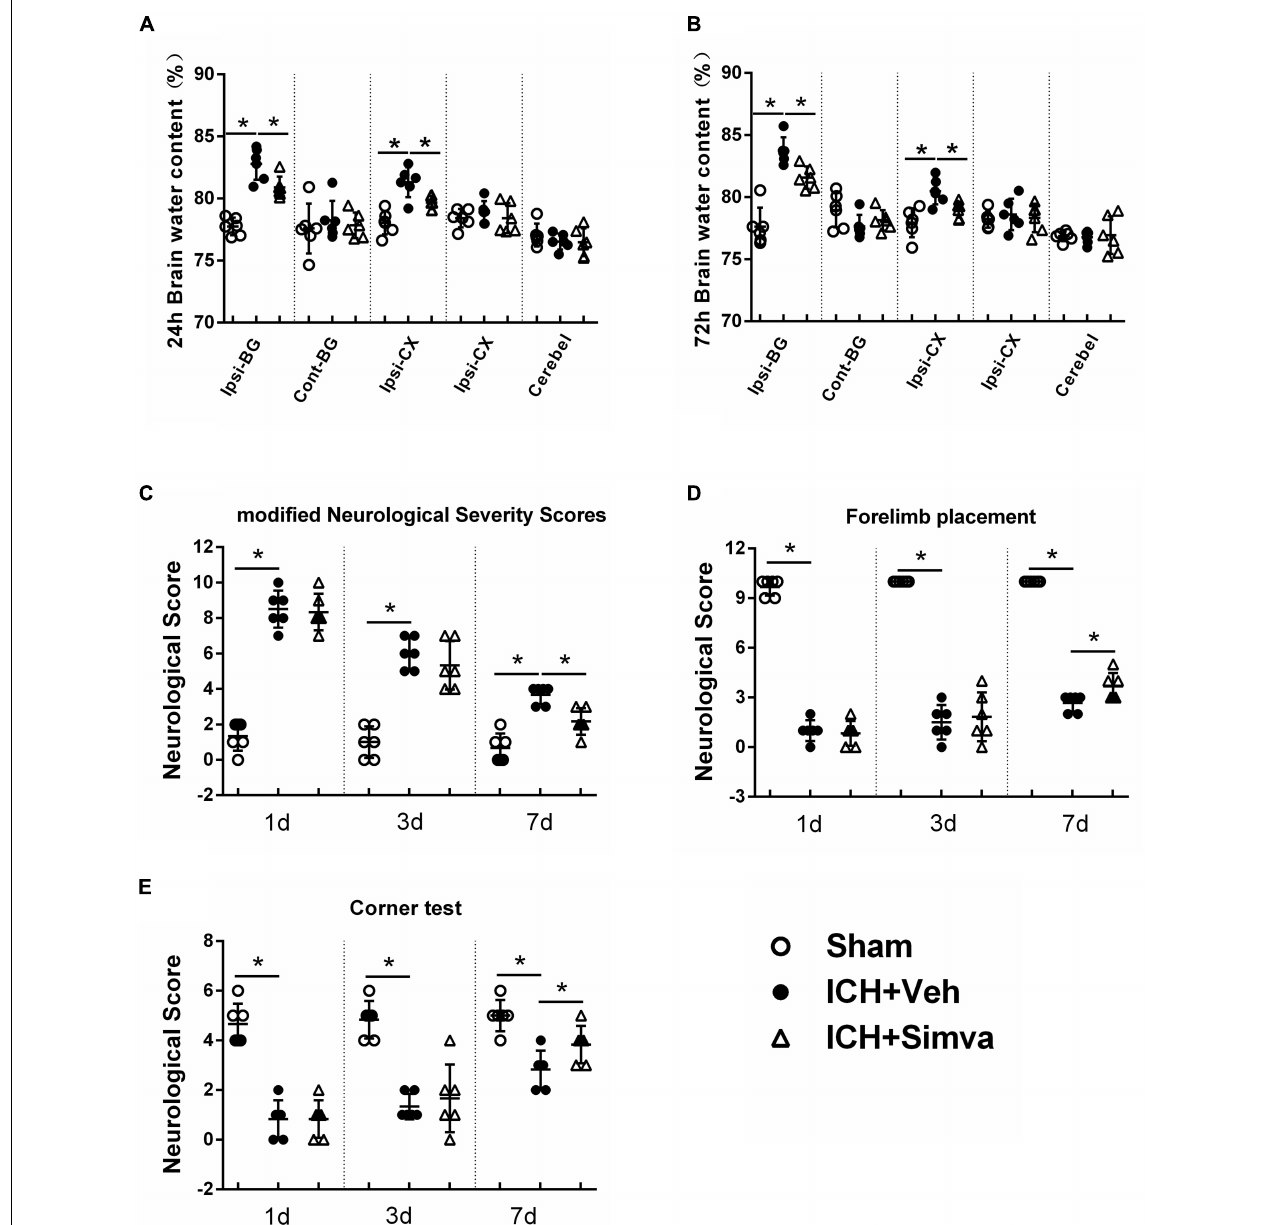
FIGURE 3 | Simvastatin significantly attenuated ICH-induced brain edema and neurological deficits. Measurement of brain water content at 24 h (A) and 72 h (B) after ICH. Values are expressed as mean ± SD, n = 6 per group; ∗ P < 0.05 versus sham group; # P < 0.05 versus ICH-Veh group. Ipsi-BG, ipsilateral basal ganglia; Con-BG, contralateral basal ganglia; Ipsi-CX, ipsilateral cerebral cortex; Con-CX, contralateral cerebral cortex; Cerebel, cerebellum. Neurofunctional assessment by using mNSS (C) , Forelimb Placement Test (D) and Corner Test (E) at the indicated time points after ICH. Values are expressed as mean ± SD, n = 6 per group; ∗ P < 0.05 ICH-Veh group versus Sham